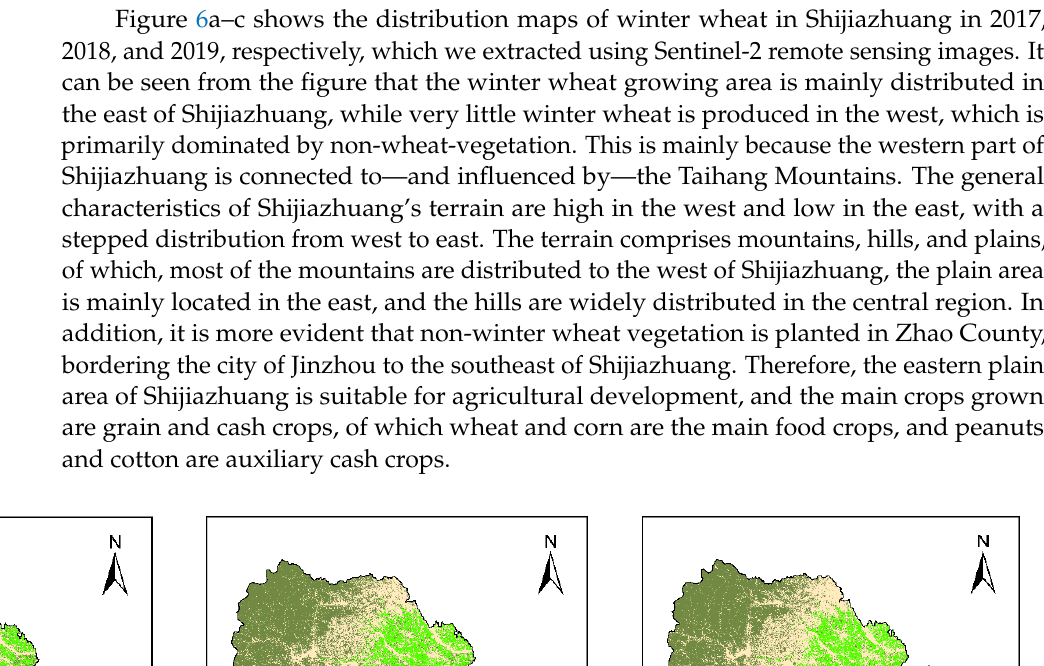
Figure 5. Changes in winter wheat area by county-level administrative region in Shijiazhuang.